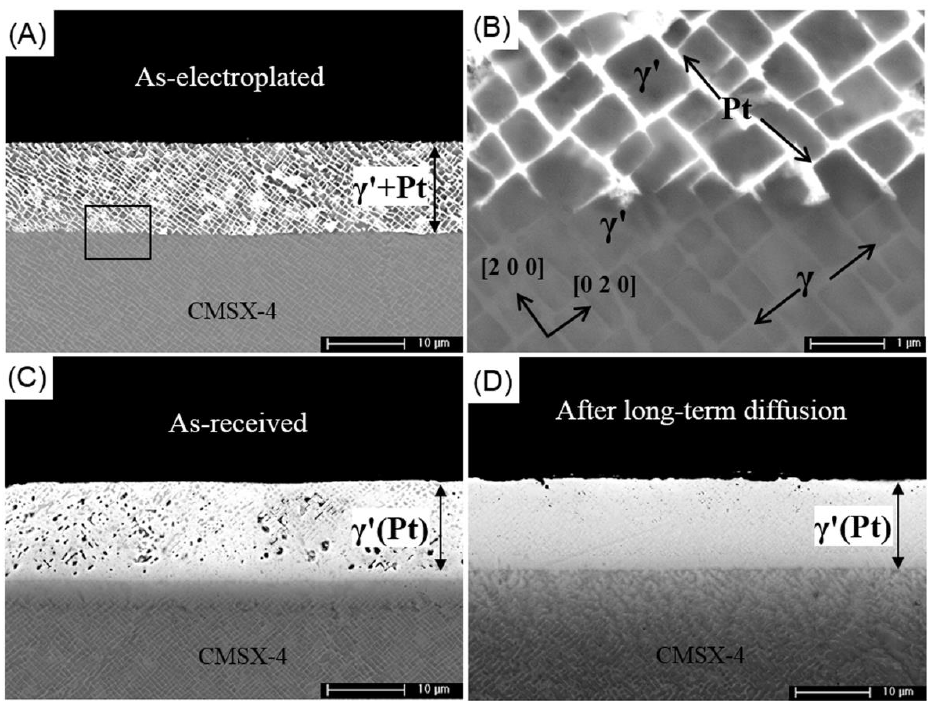
Figure 7. Cross-sectional BSE images of the Pt-diffused γ’-phase bond coat; ( A ) the as-electroplated γ-etched substrate; ( B ) enlarged image at the substrate/coating interface; ( C ) as-received after vacuum heat treatment at 1150 °C for 2 h; and ( D ) after additional 50 h in vacuum at 1150 °C. Figure 8 shows the cross-sectional BSE images and EPMA mappings of 8A the stand- ard Pt-diffused γ/γ’ bond coat and 8B the Pt-diffused γ’-phase bond coat after oxidation at 1150 °C for 50 h. After oxidation, the Pt-diffused γ’-phase bond coat remains uniform as a coherent γ’-phase layer on the substrate. The concentration of Pt and Al in the Pt- diffused γ’-phase bond coat beneath the TGO layer remains high with less depletion .